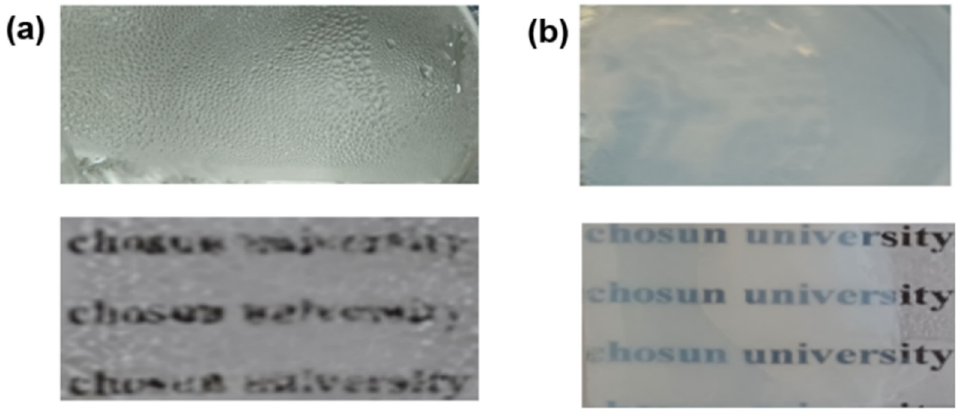
Figure 8. Anti-fogging properties of ( a ) bare glass and ( b ) TiO 2 ̶ KH550 ̶ PEG -coated glass.